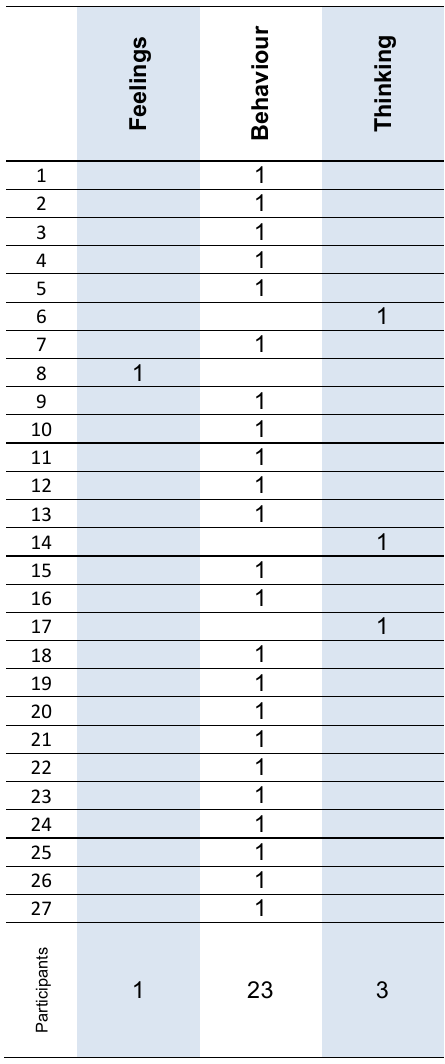
Table 7: Results of Brief Script Questionnaire: